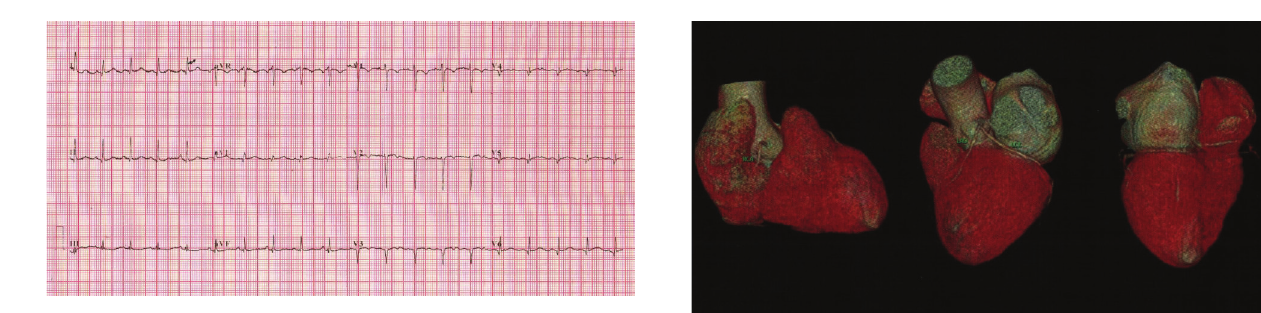
Figure 4: Electrocardiogram obtained 2 months after the acute coronary syndrome. It shows normalization of T wave in leads I, aVL, II, III, aVF, and V4–V6.